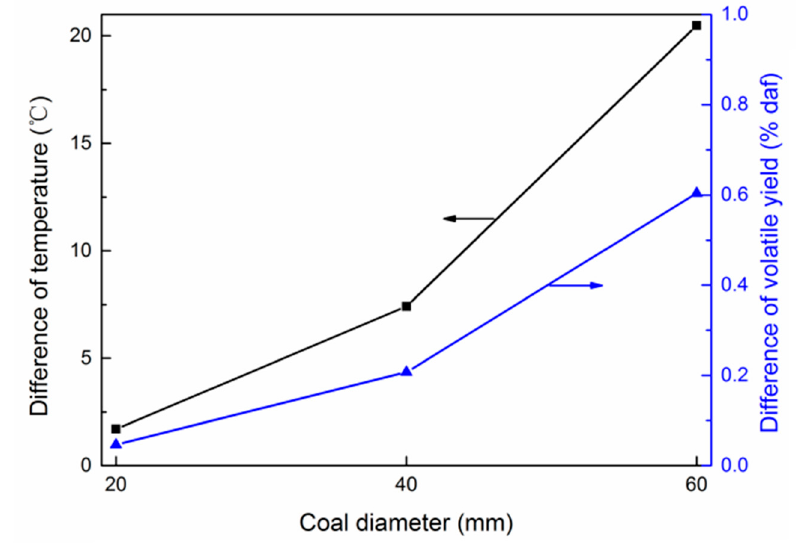
Figure 9. The difference in temperature and volatile yield between the external layer and core of three coal particles with different diameters at the end of heating.